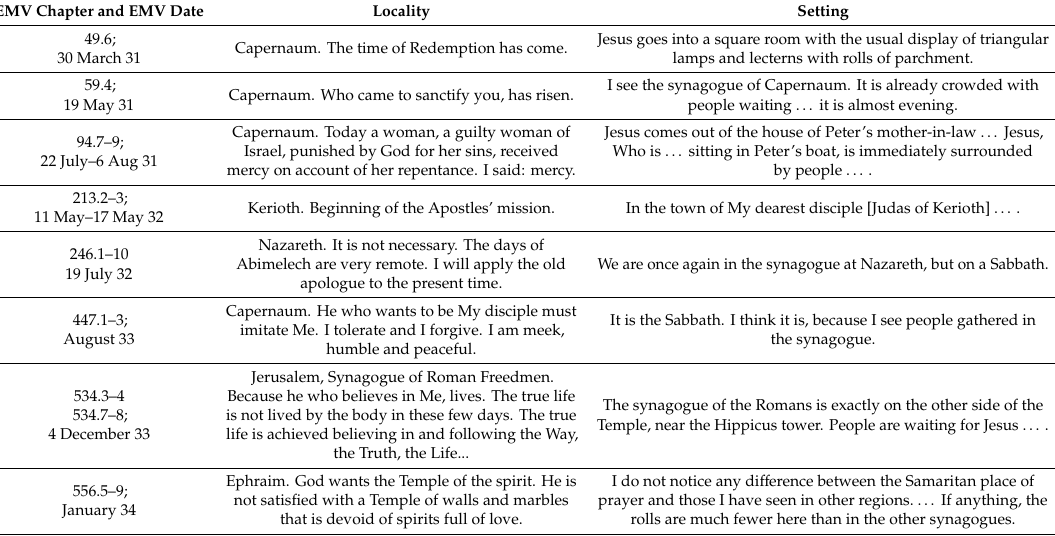
Table A1. Date, locality, a brief mention of the topic and setting of the speeches delivered in Synagogues (8